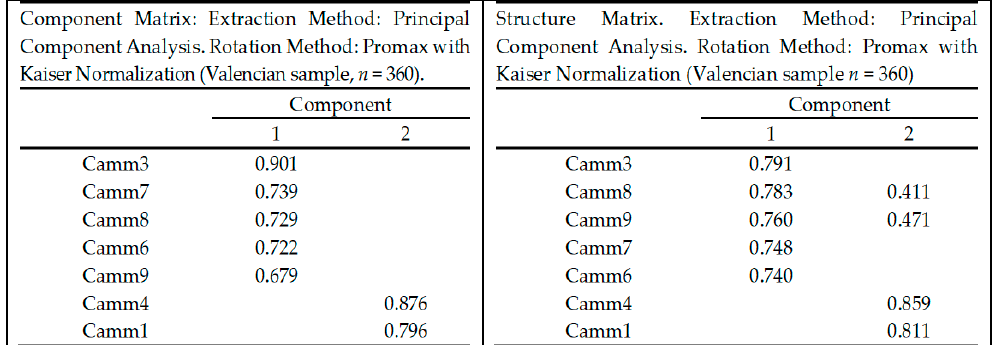
Figure 1. Component matrix and structure after exploratory factor analysis (EAF) using Valencian sample ( n 1 = 360). After EFA, seven items finally remained.